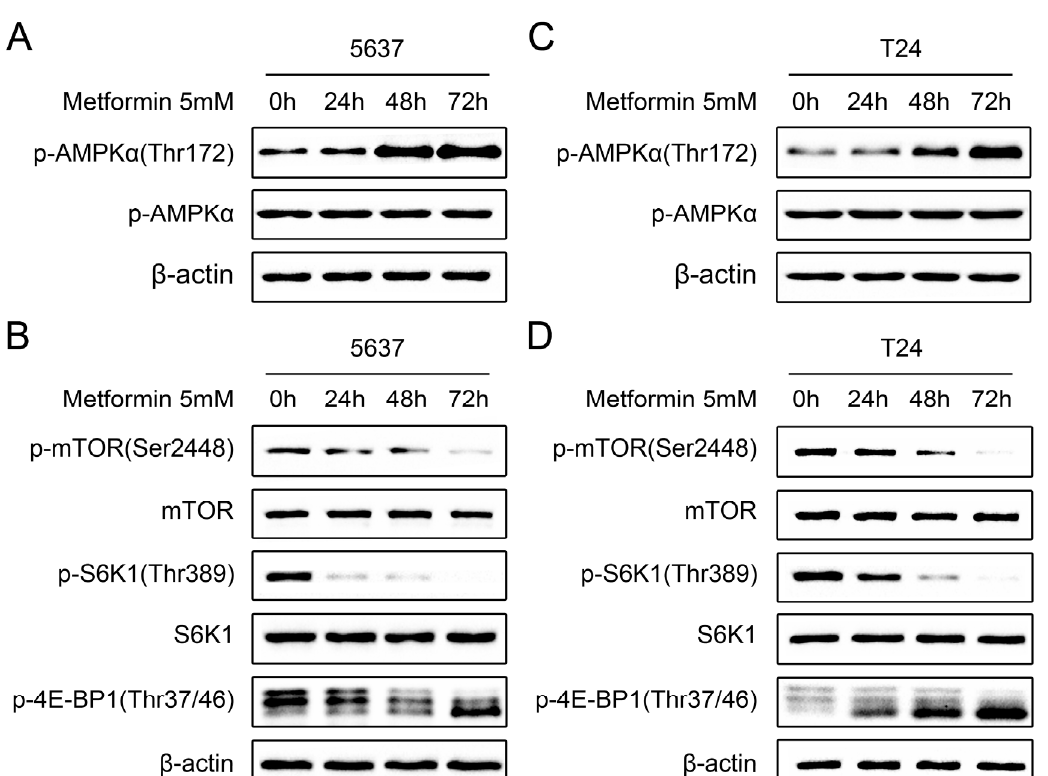
Figure 4. Metformin activates AMP-activated protein kinase (AMPK) and inhibits mammalian target of rapamycin (mTOR) signaling in bladder cancer cells. 5637 and T24 cells were treated with 5 mM metformin for the indicated time and the lysates were immunoblotted with the indicated antibodies. ( A , C ) Effects of metformin on the phosphorylation of AMPK in 5637 ( A ) and T24 cells ( C ); and ( B , D ) Effects of metformin on mTOR signaling in 5637 ( B ) and T24 cells ( D ). Data shown are representative of three independent